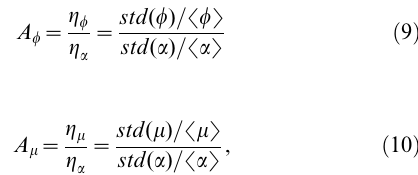
The symbol S ::: T means that the parameters are measured at the stable state.